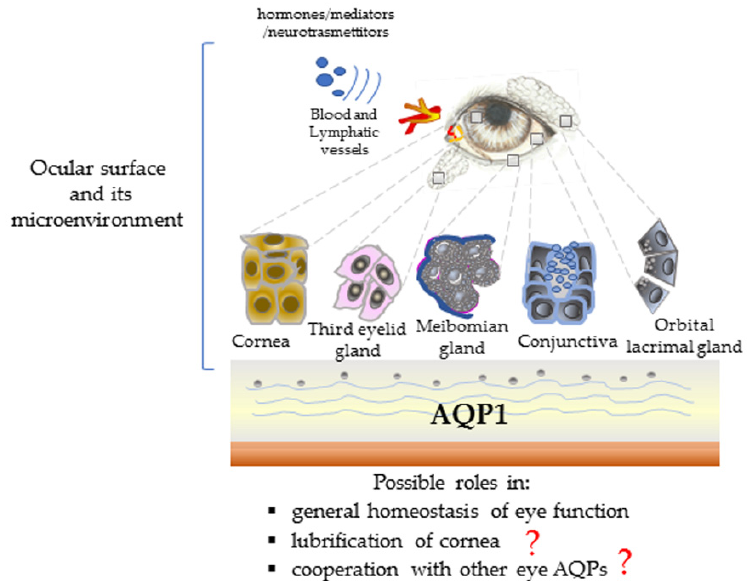
Figure 7. Scheme illustrating the possible roles of AQP1 in the lacrimal functional unit (LFU) of the